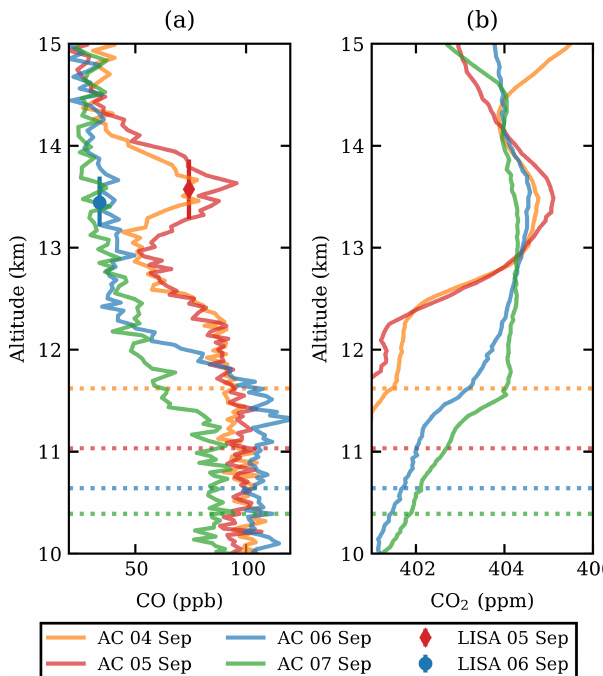
Figure 1. The CO (a) and CO 2 (b) profiles from AirCore (lines, ab- breviated as AC in the legend) and the LISA sampler (markers). The profiles are shown between 12 and 15km altitude and are coloured by date. The LISA sampler vertical error bars represent the total vertical coverage of the sample, with the mean altitude as shown. For mole fraction measurement uncertainties, the reader is referred back to Sect. 2.2.1. The tropopause is indicated as a dashed line, matching the colour of the respective AirCore